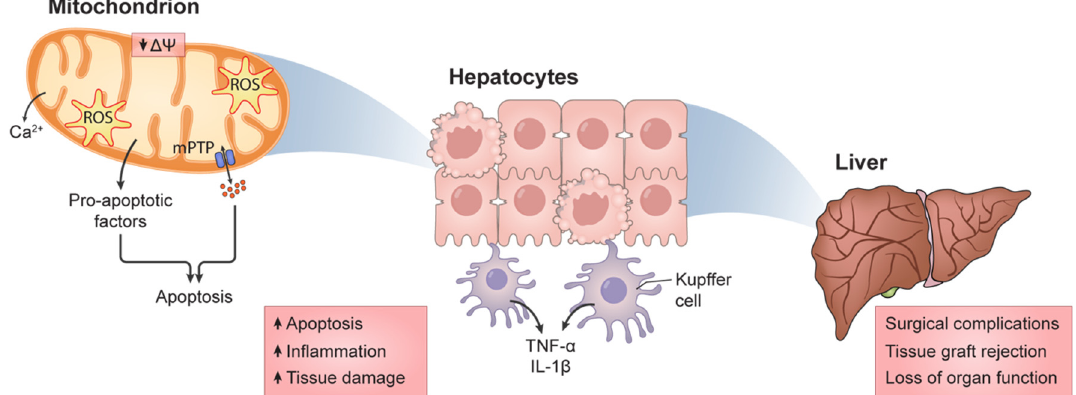
Figure 1. The upscaling of damage in HIRI. Severe compromise to mitochondrial function results in the exacerbated generation of reactive oxygen species (ROS), resulting in the activation of pro-apoptotic protocols such as the opening of the mitochondrial permeability transition pore (mPTP) and release of pro-apoptotic factors, such as ionic calcium (Ca 2+ ). While mitochondrial Ca 2+ release is markedly lower when compared with other Ca 2+ sources that could lead to elevated levels (for example, the endoplasmic reticulum or from extracellular sources), the damage to mitochondrial function and integrity will undoubtedly lead to the release of Ca 2+ and other pro-apoptotic factors. Furthermore, these sources could initiate mitochondrial dysfunction, rather than mitochondrial injury per se. Regardless, given enough replication of these phenomena, cellular survival is at risk, which in turn is a marker for further damage, due to the activation of sterile inflammatory procedures. All these processes, if left unchecked, might result in tissue loss and, eventually, organ failure.